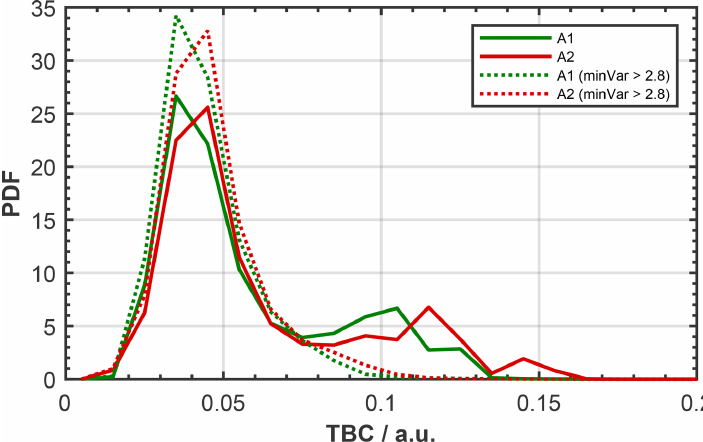
Figure B2. Example comparison of TBC distributions of a VOAG data set of spherical particles (5µm PEG) when the minimum variance criterion of 2 . 8 is (dotted) and is not (solid) applied. Green lines correspond to array 1 and red to array